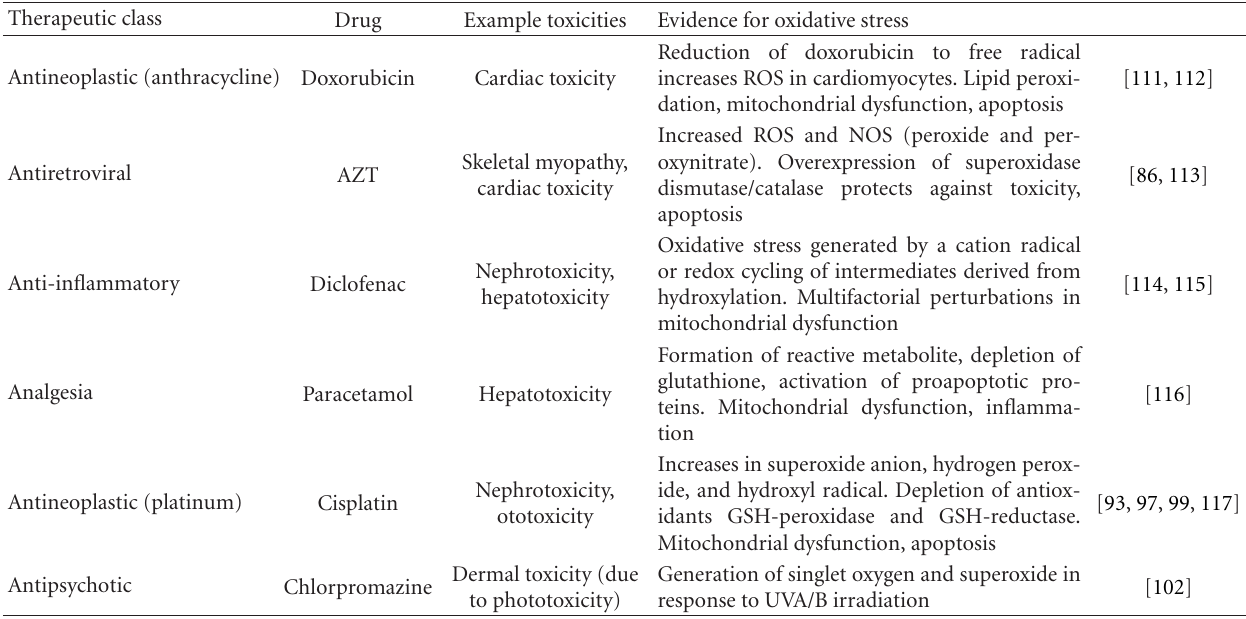
Table 1: Examples of toxicities associated with drug-induced oxidative